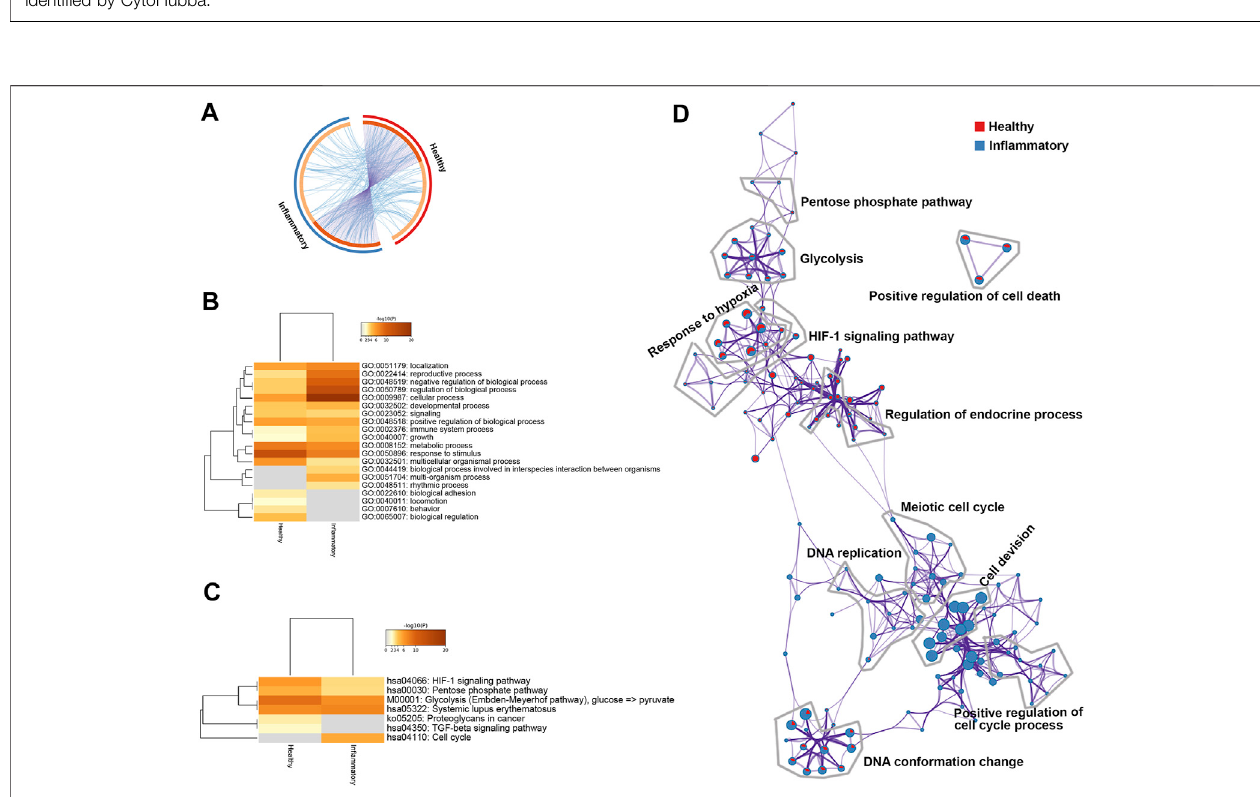
FIGURE 5 | Differentially expressed genes (DEGs) in healthy or in fl ammatory hPDLSCs. (A) Circos plot showing the overlap between the DEGs under the two conditions. (B) MostenrichedGeneOntology(GO)biologicalprocessesdeterminedusingMetascape.Theprocessesarecoloredaccordingtothe p value. (C) Heatmap of enriched Kyoto Encyclopedia of Genes and Genomes (KEGG) pathways determined using Metascape. The processes are colored according to the p value. (D) Network of enriched terms in pie charts. The red color represents enriched terms under healthy condition and blue color represents enriched terms under in fl ammatory